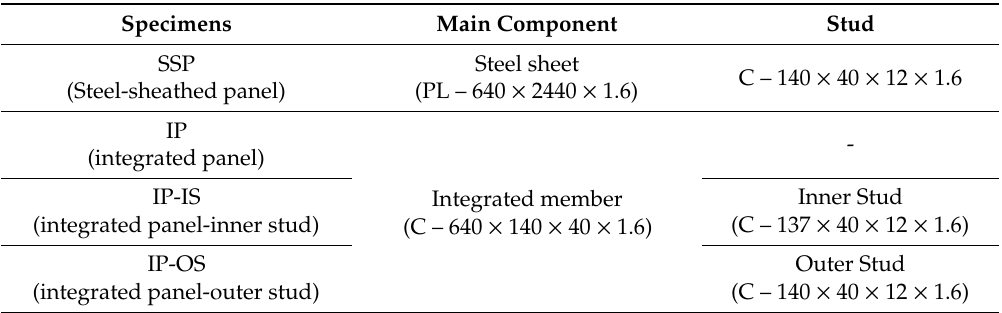
Table 1. Test specimens